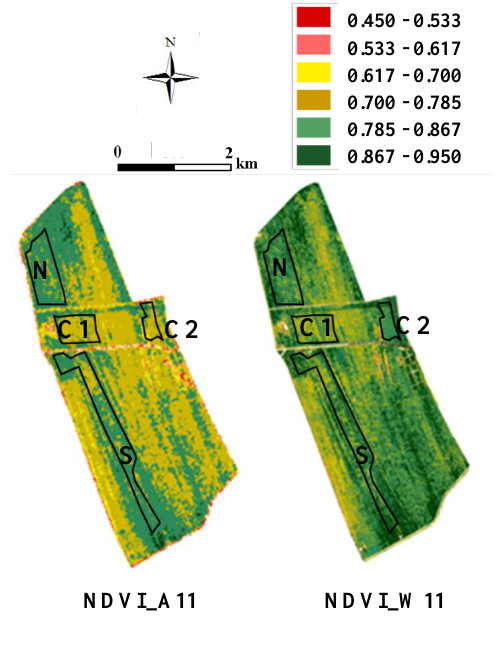
Figure 3. Classe NDVI maps